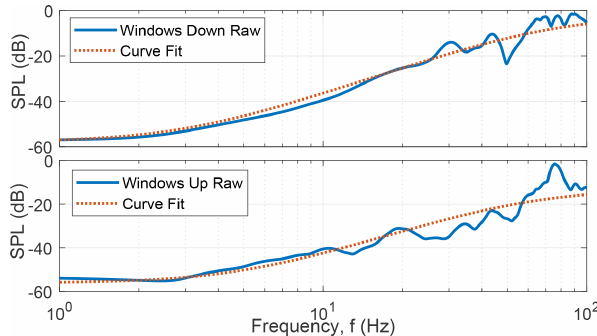
Figure 8. Experimental transfer function data and fitted models for windows up and windows down configurations.